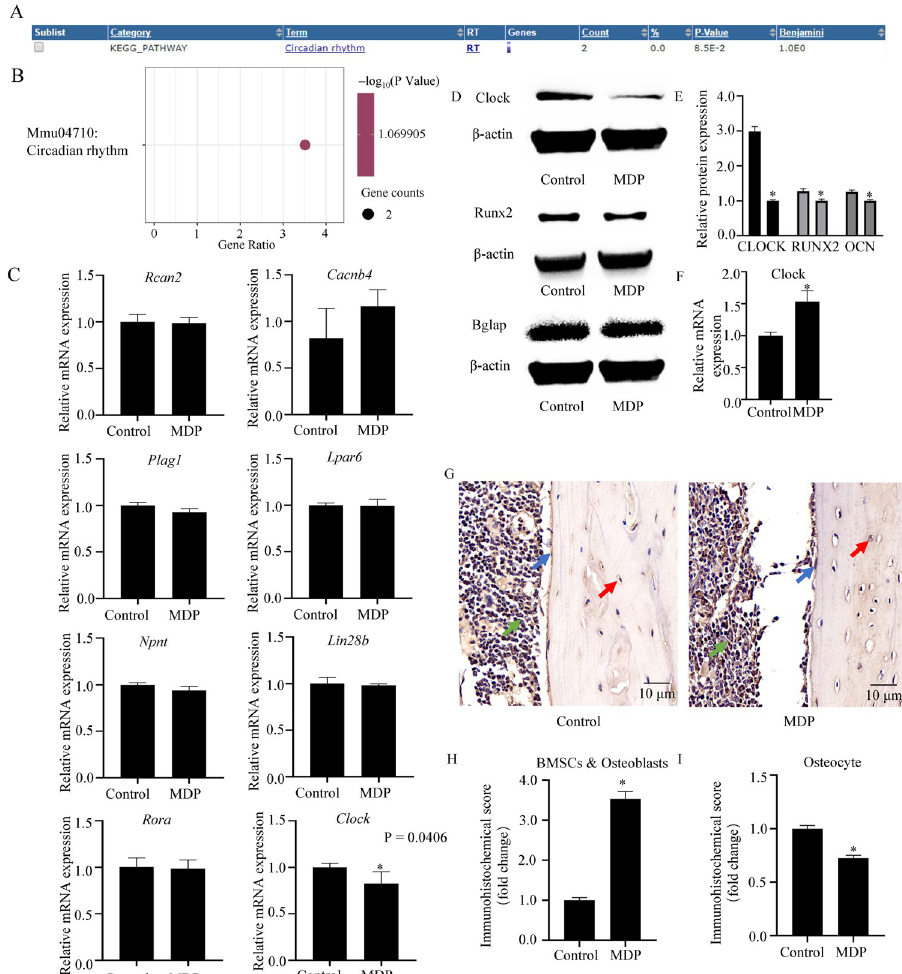
Fig 4. Bioinformatics analysis of the gene pathways that were enriched in the N.g MDP–treated osteocytes and verification in vitro . (A and B) Pathway enrichment analysis showed that the differentially expressed genes, including clock and Rora, were associated with Circadian rhythm pathways. The size of the nodes and the intensity of the color indicate the gene number and mean P value. (C) qRT-PCR showed decreased expression of clock mRNA, n = 3. (D) Western blots showed decreased expression of CLOCK, RUNX2, and BGLAP. (E) Quantitative analysis of the expression of CLOCK protein. n = 3. (F) qRT-PCR showed increased expression of clock mRNA after osteogenic induction. (G) In vivo, immunohistochemistry showed increased CLOCK expression in bone mesenchymal stem cells (BMSCs) and osteoblasts, but decreased expression in osteocytes. Scale bar = 10 μ m. (H and I) Quantitative analysis of immunohistochemical score of (G). Green arrow, BMSCs; blue arrow, osteoblast; red arrow, osteocyte; Control, the sample was treated with culture medium in vitro or saline only in vivo; MDP, the sample was treated with 1 μ g/ml